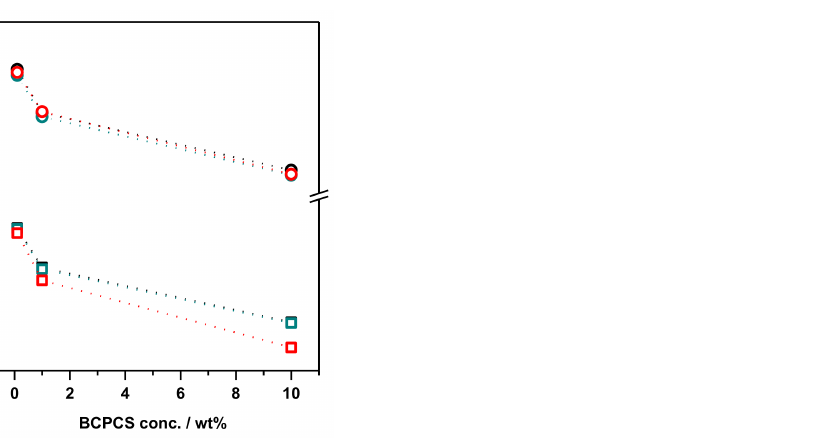
Figure 4. Self-diffusion coefficient values ( D ) as a function of BCPCS concentration in intact samples. Symbols denote the C 12 TA + ion ( ) and polyion ( (cid:3) ) in C 12 S; the C 16 TA + ion ( ) and polyion ( (cid:3) ) in (cid:35) (cid:35) C 16 S; and the C 12 TA + ion ( ) and polyion ( (cid:3) ) in C 12 L. The lines are guides for the eye. The terms C 12 (cid:35) and C 16 refer to the surfactant alkyl chain length, whereas S and L refer to the length of the PAAm block in the BCP (short and long, respectively). Table 3. Self-diffusion coefficients (D) for surfactant ions, polyions, and HMDSO in intact samples at 1 wt% BCPCS.